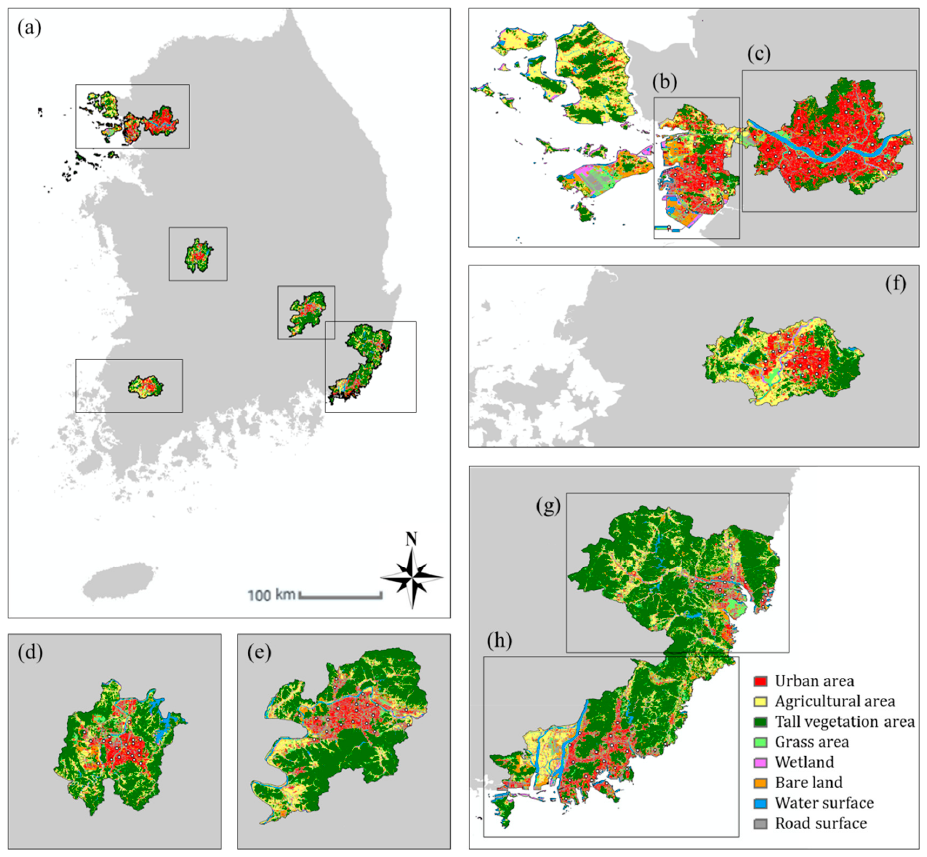
Figure 1. Location of the research areas in ( a ) South Korea, and land cover distributions in the capital and metropolitan areas. ( b ) Incheon (islands excluded); ( c ) Seoul; ( d ) Daejeon; ( e ) Daegu; ( f ) Gwangju; ( g ) Ulsan; and ( h ) Busan. In the figures ( b ) to ( h ), the weather observation sites of the Korea telecom (KT) corporation network in the urban area have been indicated (gray dots). Table 1. Climate, area, and observed temperatures for each research area (from June to August for 2010–2019; the maximum values are provided in parentheses).